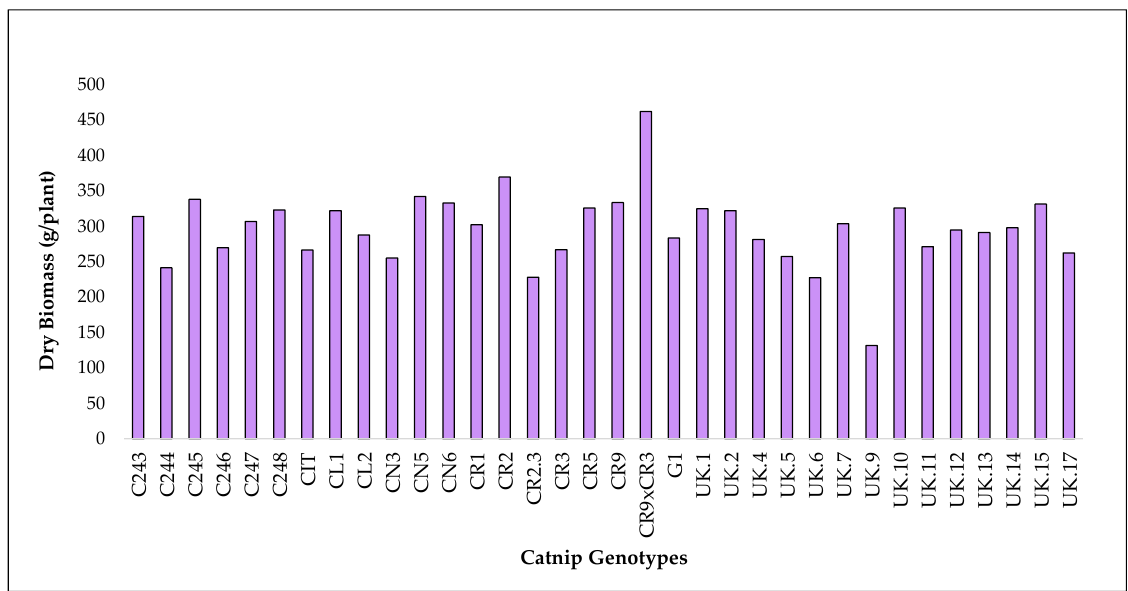
Molecules 2022 , 27 , x FOR PEER REVIEW 12 of 20